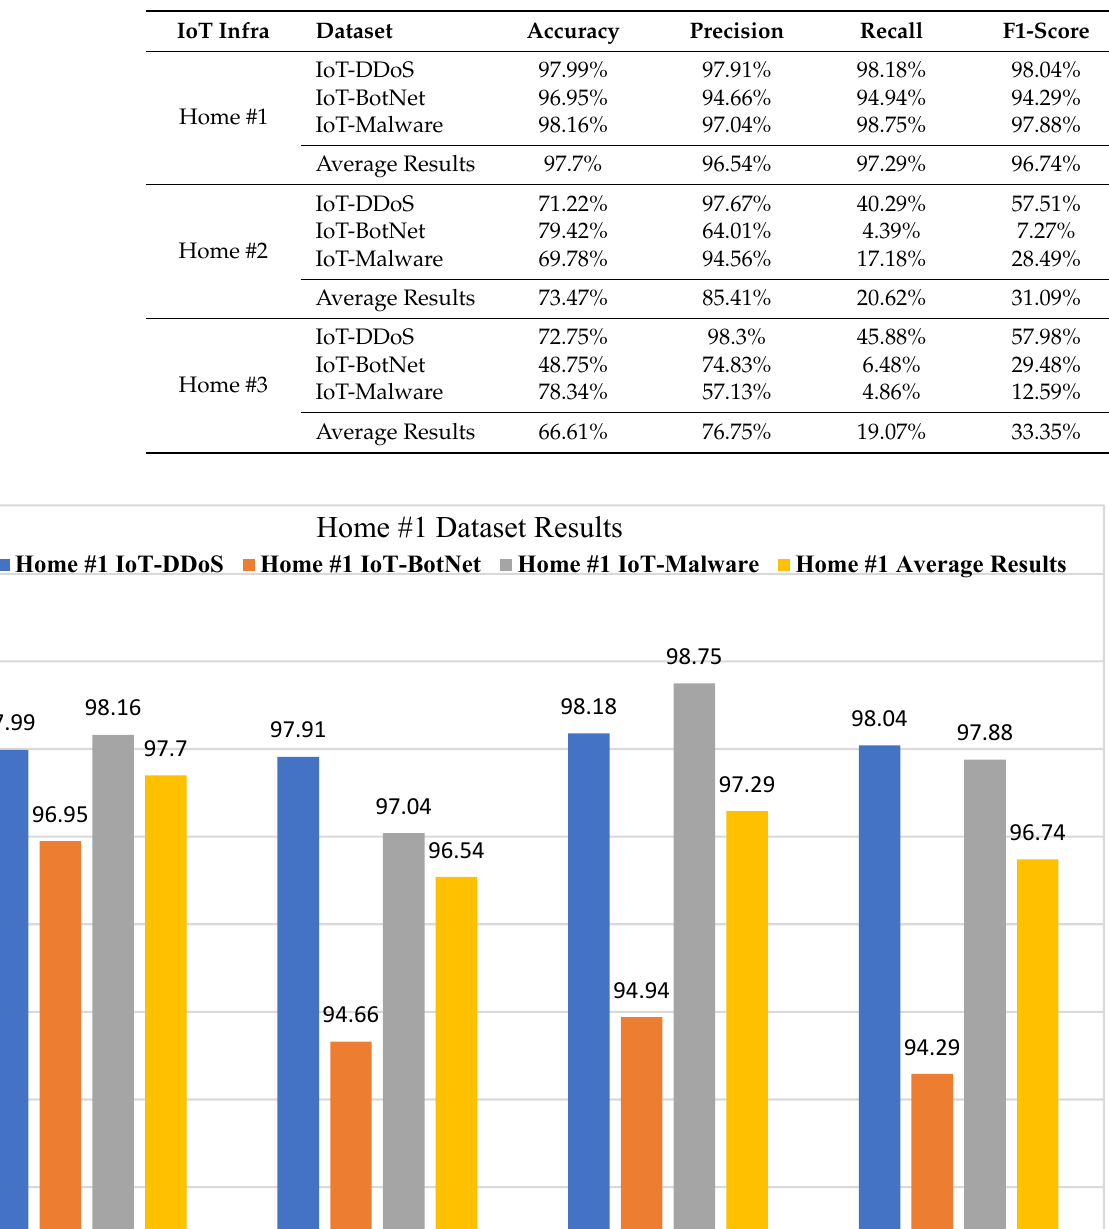
Table 9. Summary of attack-traffic results.